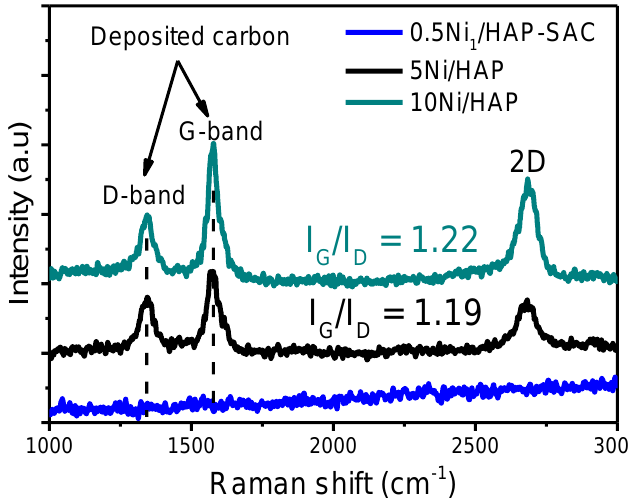
Figure 13. Raman spectra of spent 0.5Ni 1 / HAP-SAC and 5Ni / HAP-NP and 10Ni / HAP-NP after reaction at 750 °C.